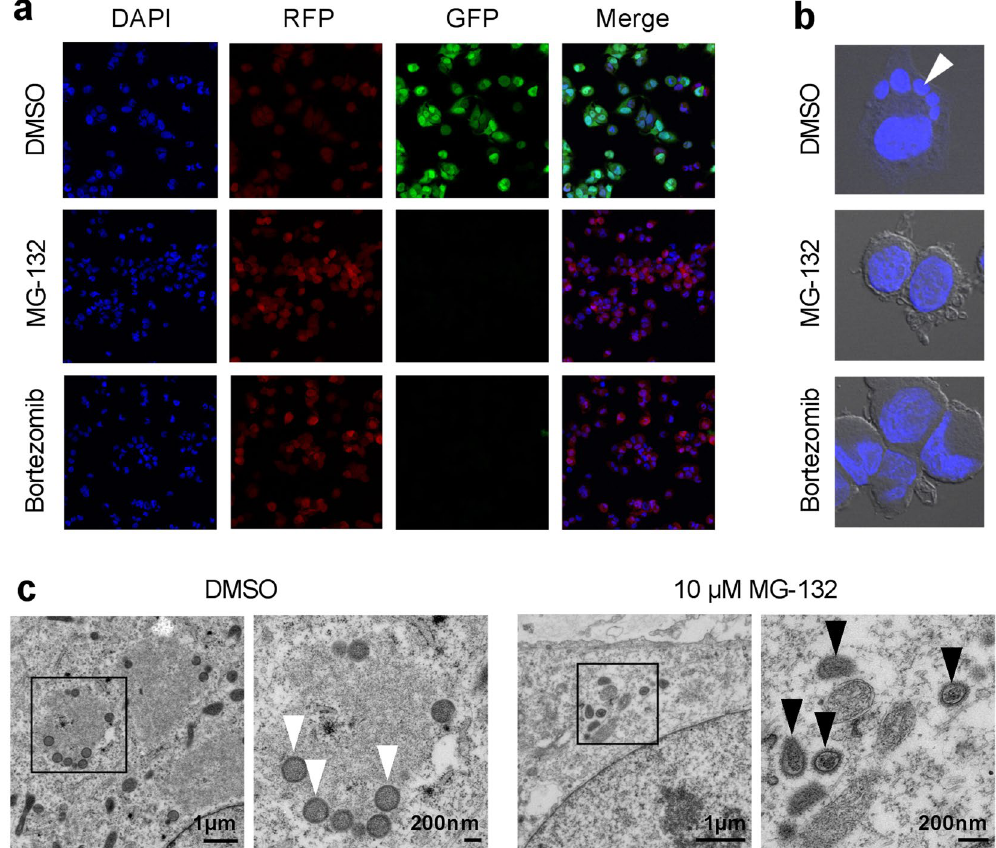
Figure 3. Proteasome inhibition impairs CPXV late protein expression and virus factory formation by prevention of uncoating. ( a , b ) HeLa cells were infected with CPXV BRFseR expressing RFP under an early viral promotor and GFP under a late viral promotor at an MOI of 5 in the presence or absence of 10 µ M MG-132 or 1 µ M Bortezomib. After 8 h cells were fixed and stained with DAPI. ( a ) Inhibitor-treated cells display no late protein expression, while early protein expression is still detectable. RFP fluorescence in control cells is overlaid by GFP fluorescence and hence appears less intense. ( b ) While cells with non-inhibited proteasome (DMSO) display typical virus factories in the cytoplasm (white triangle), these structures were absent in proteasome inhibitor-treated cells. ( c ) HeLa cells were infected with CPXV BRFseR at an MOI of 100 in the presence of 10 µ M MG-132 or DMSO and subjected to transmission electron microscopy 4 h post infection. Virus factories and immature virus particles (white arrows) were only detected in cells treated with DMSO, while intact cores (black arrows) were regularly found in cells treated with proteasome inhibitor